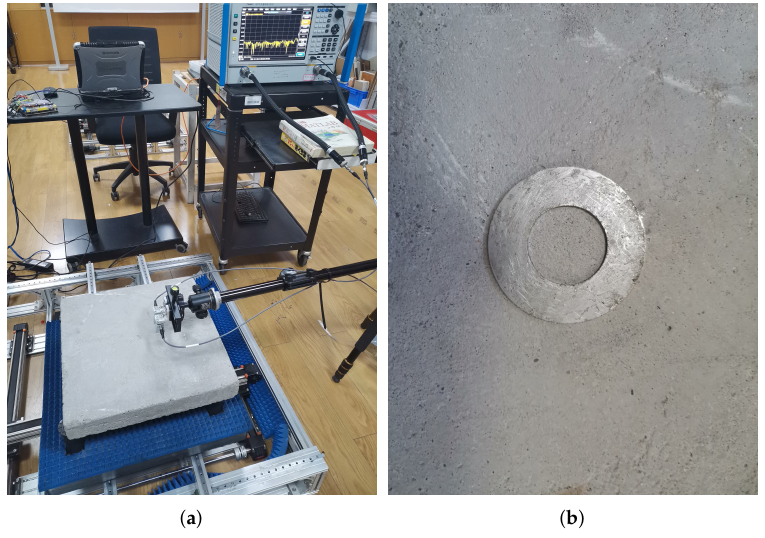
Figure 3. Photograph of measurement setup of Scene I. ( a ) View of the test scene. ( b ) Hidden